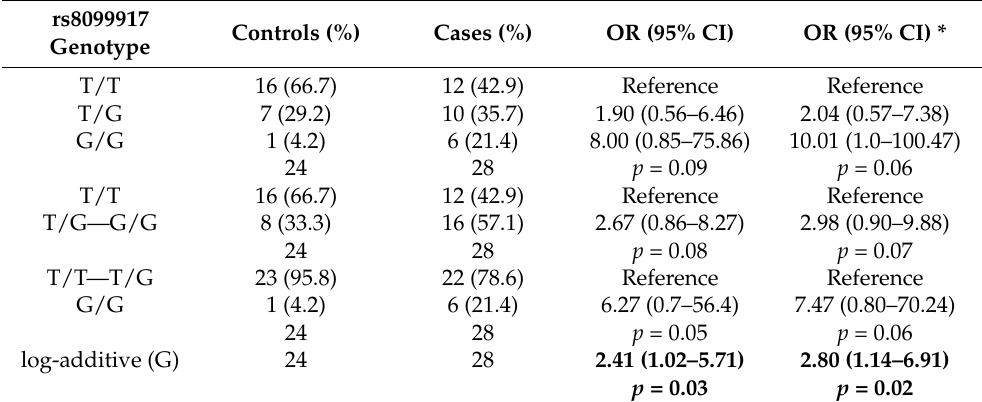
Table 1. Association between polymorphism rs8099917 and congenital Zika syndrome in a cohort from Campina